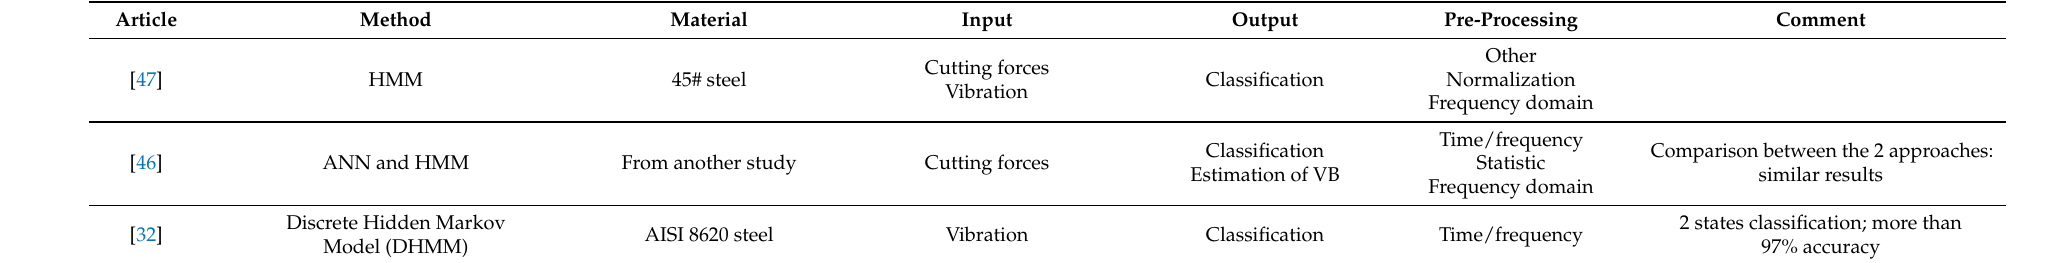
Table A6. General summary of HMM-related